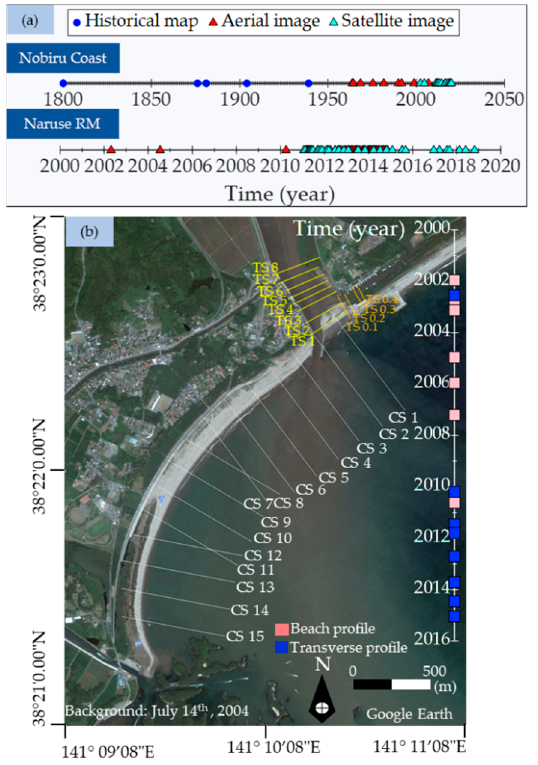
Figure 6. ( a ) Collected data set of historical map and images. ( b ) In situ profile surveys. For each image, a series of ground control points (GCP) was selected and assigned to a spatial reference system, WGS84/UTM Zone 54S. All images were then geo-referenced and transformed into orthophoto images by utilizing a projective matrix as the image transformation method and bilinear interpolation as the image resampling method. The shoreline from each image is consistently defined as the wet–dry line or the high-water line (HWL), from which the division between the dark (wet) and light (dry) sand on the beach is extracted [32]. The K-means clustering algorithm based on the clustering technique was applied to classify the wet and dry sand areas into two different groups (clusters).